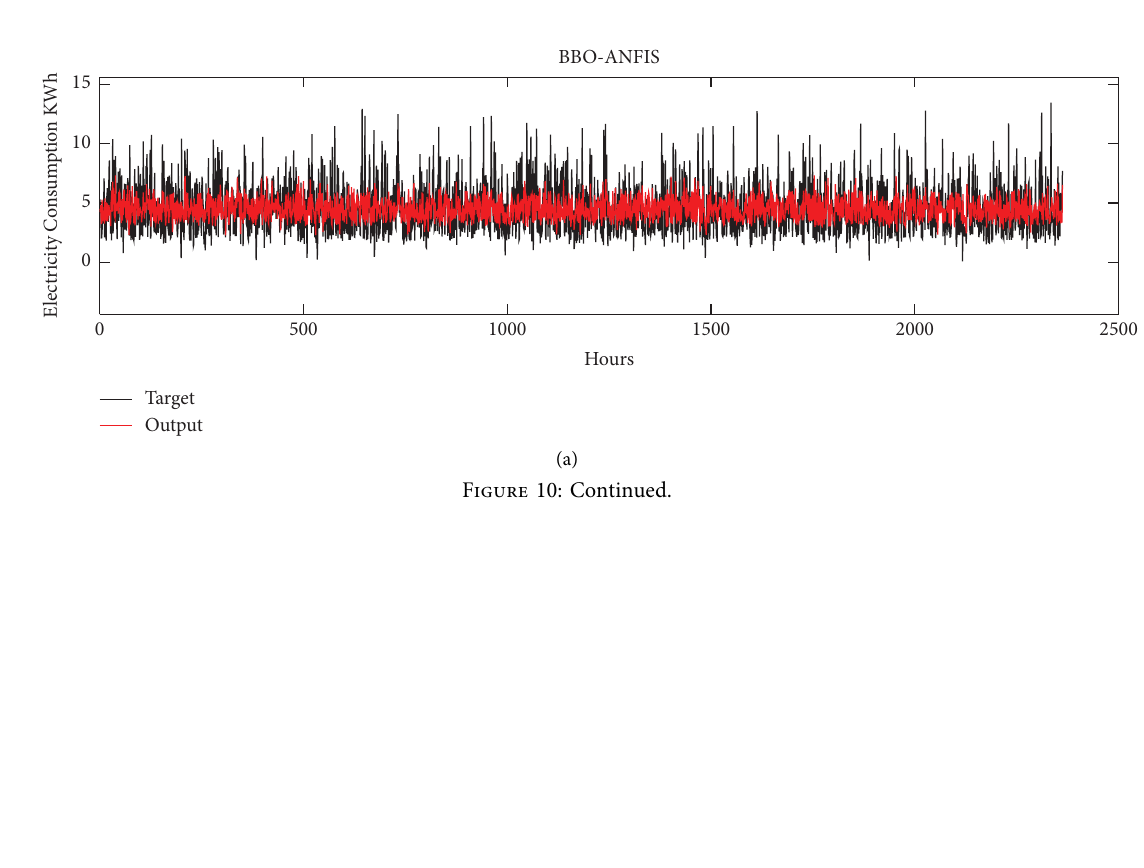
Figure 9: Plot of the DE-ANFIS model.